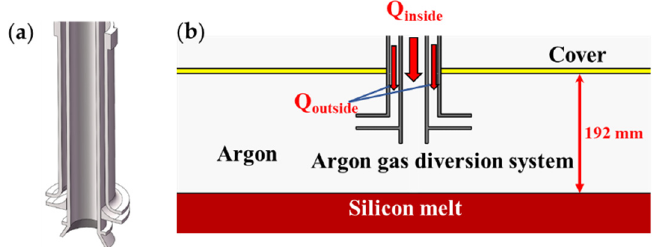
Figure 2. Schematic diagram of 3D ( a ) and 2D ( b ) structure of AGDS.